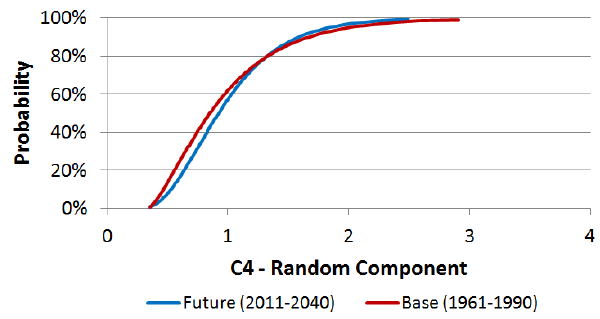
Figure 15. Adjustment of the Gamma distribution for the model- ing of the random component in a high flow situation, C3( t ) higher than 1, for the base and future